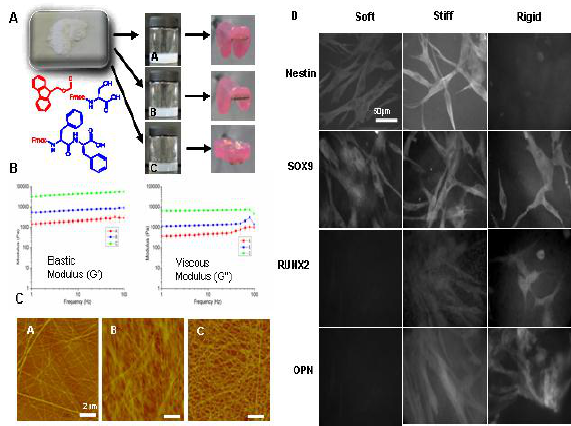
FIGURE 1: A: chemical structures of Fmoc-FF, Fmoc-S and Fmoc and photograph of three pre gelation mixtures and three hydrogels. B: Elastic and Viscous modulus spectra for three gels. C: AFM images for pre gelation mixtures which showing fibrous morphology. D: immunostaining results for nestin, SOX9, Runx2 and OPN